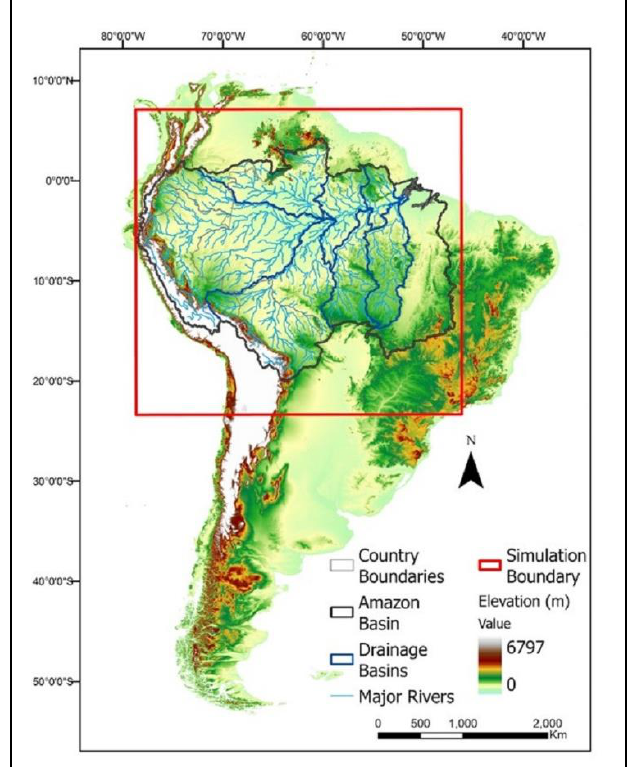
Figure 1. Geographic location of the Amazon Basin. The red box indicates our simulation